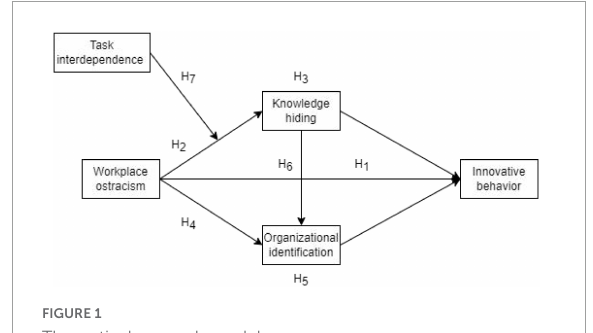
FIGURE1 Theoretical research